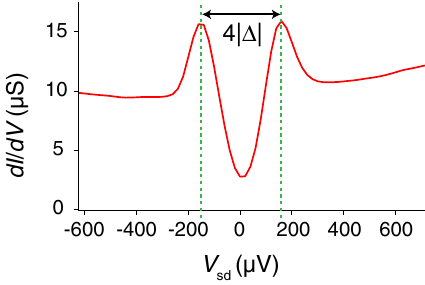
FIG. 9. Signature of the superconducting 50-nm-thick alumi- num leads. The differential conductance vs bias voltage shows the presence of a superconducting gap around zero bias, as well as the cotunneling peaks arising from the quasiparticle tunneling. The gap value (cid:2) (cid:4) 80 (cid:6) eV is thus obtained from the 4(cid:2) -wide gap denoted by the double arrow. The measurement is performed in a blocked region of the nano-SQUID, which explains why no supercurrent is visible at zero